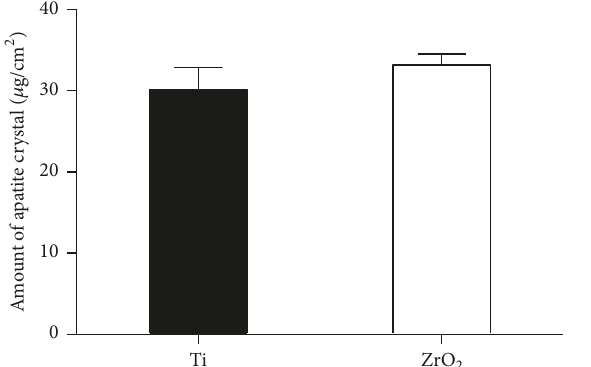
Figure 3: Estimated amounts of apatite formation on Ti and ZrO 2 24 hours after SBF injection. No significant difference between Ti and ZrO 2 ( 𝑝 > 0.05 ).